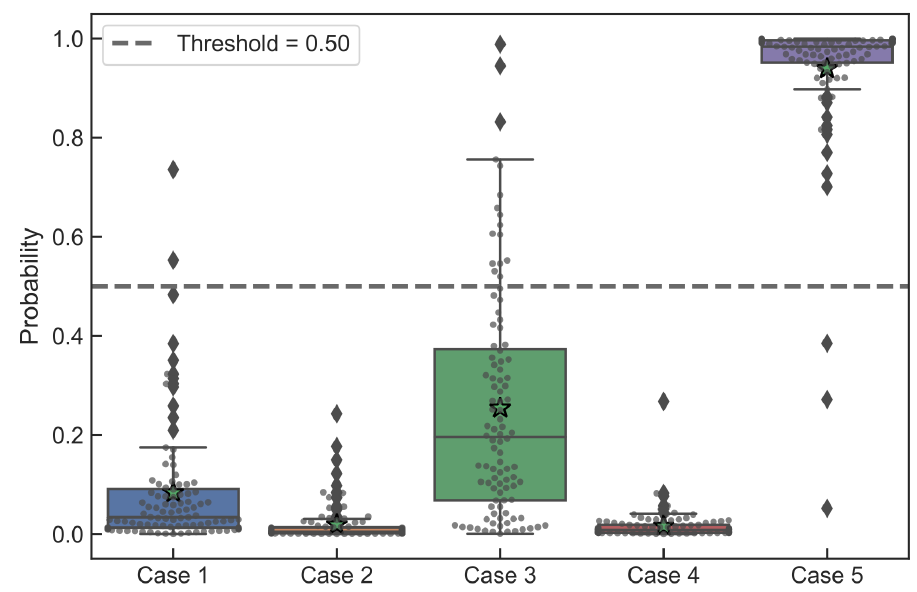
Figure 12. Monte Carlo determined statistical distribution of prediction probabilities from a DNN classifier for a few select cases (Cases 1 through 4 belong to the stable class, while the Case 5 belongs to the unstable class). Boxplot: bottom and top lines of the box represent, respectively, first (Q1) and third (Q3) quartiles; the line inside the box is the median value (Q2); “whiskers” represent the lowest datum still within the 1.5 IQR (interquartile range) of the lower quartile, and the highest datum still within the 1.5 IQR of the upper quartile; diamond points outside the whiskers represent outliers; “star” indicates the mean